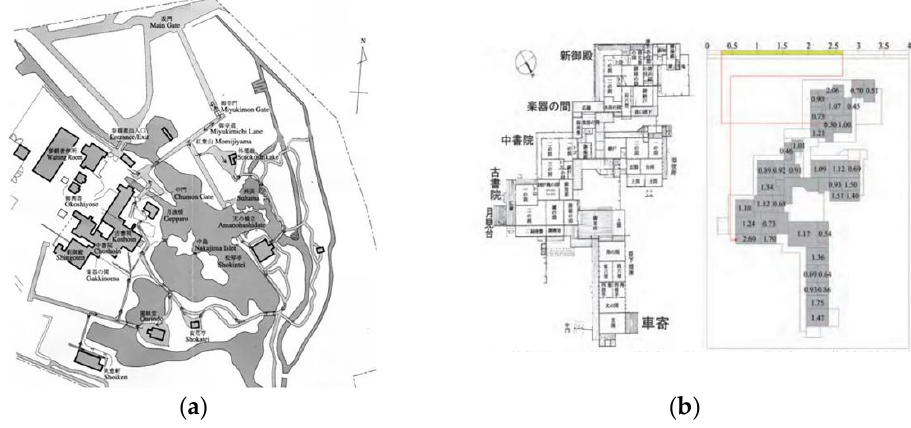
Figure 10. ( a ) Top view of Katsura Imperial Villa (source: online); ( b ) modular map of Katsura Imperial Villa Academy (source: Chou Tao's thesis).